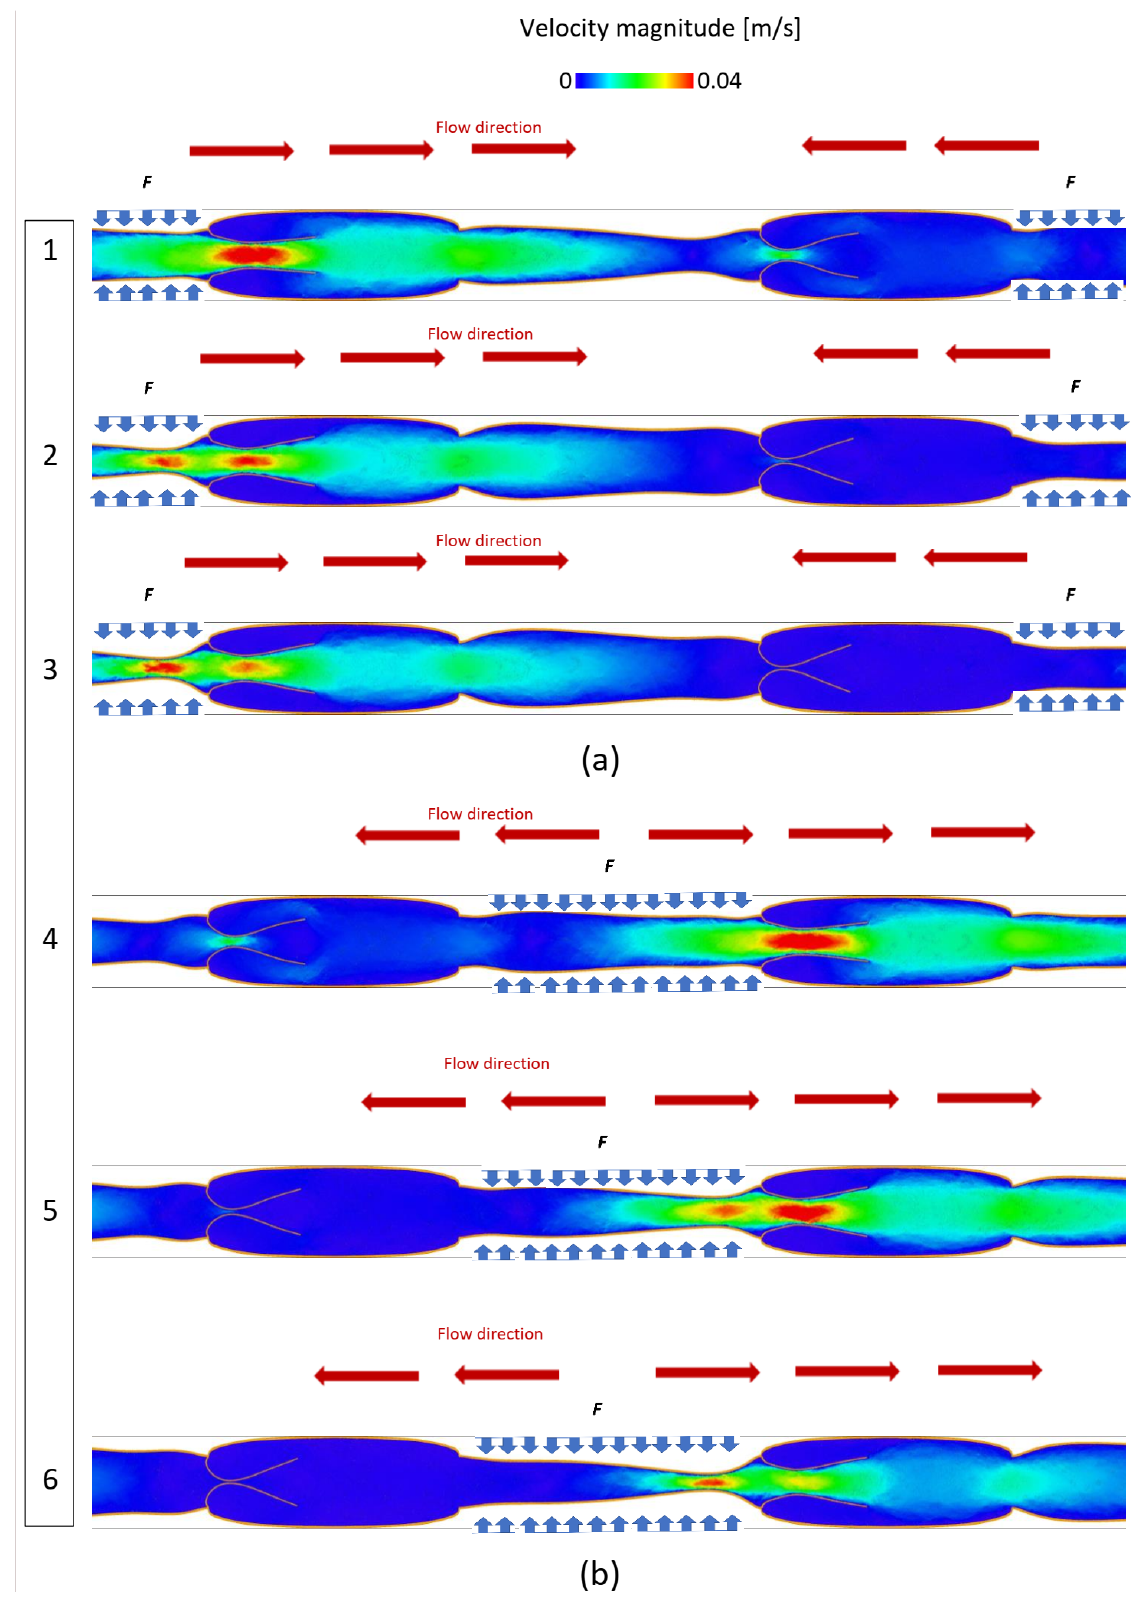
Figure 3. Velocity magnitude in the valve during opening and closing phases: ( a ) F is applied to the channel 1 and ( b ) F is applied to the channel